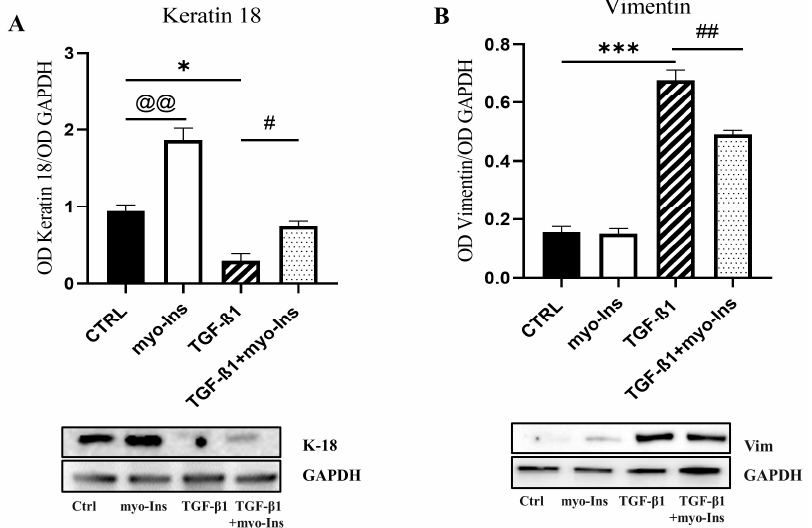
Figure 7. Myo-Ins modulates the expression of CSK microfilaments when added after five days of TGF- β 1 induction. Graphs representing Western blot relative expression of keratin-18 ( A ) and vimentin ( B ) in MCF-10A cells treated with TGF- β 1 alone or in combination with myo-Ins for six hours of three independent experiments (mean ± SEM). The addition of myo-Ins reverts almost completely the e ff ects fostered by TGF- β 1 upon intermediate fi laments, by decreasing vimentin and augmenting keratin-18. Each sample data was normalized by referring to the relative expression of GAPDH. * p < 0.05; *** p < 0.001 (One-way ANOVA). The uncropped blots are shown in Figure S2. # p < 0.05; ## p < 0.01; @@ p < 0.01. Legend: *: TGF- β 1 vs. CTRL; # TGF- β 1+myo-Ins vs. TGF- β 1; @: myo-Ins vs. CTRL.